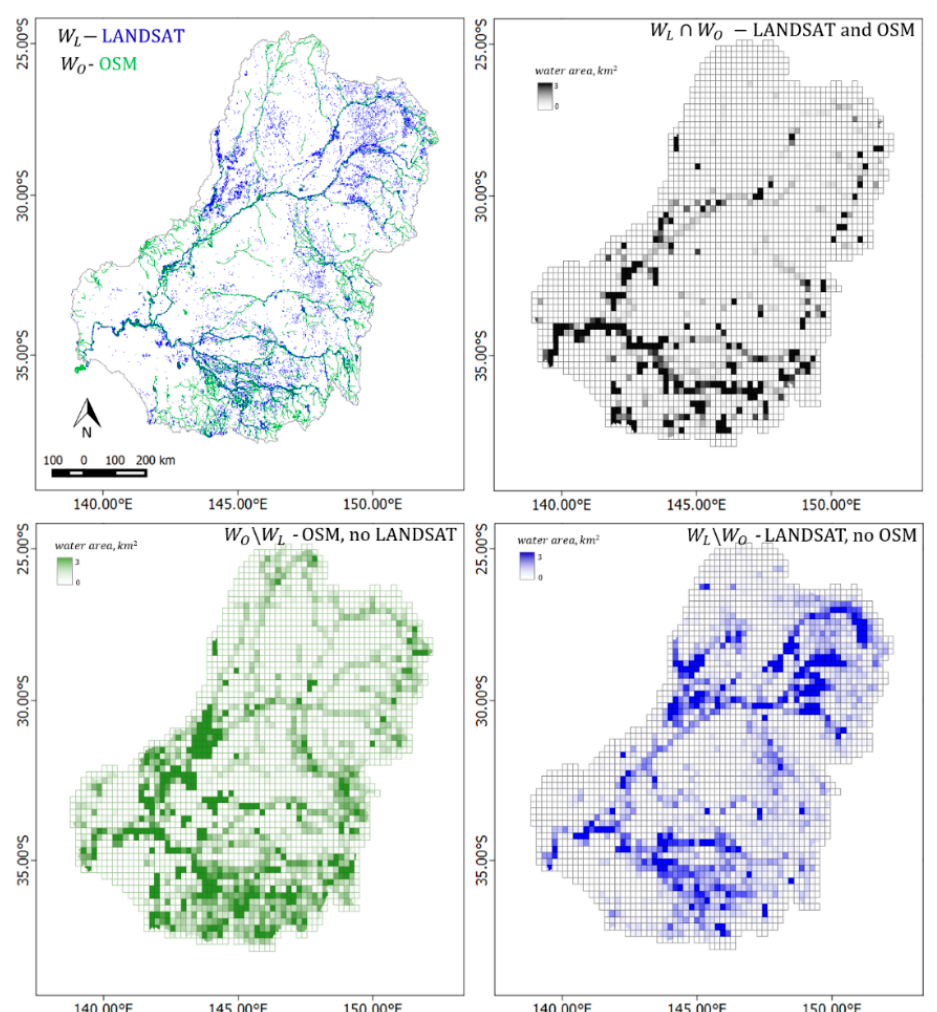
Figure 17. Thematic differences between water surface area provided by OSM and detected using Landsat 8.